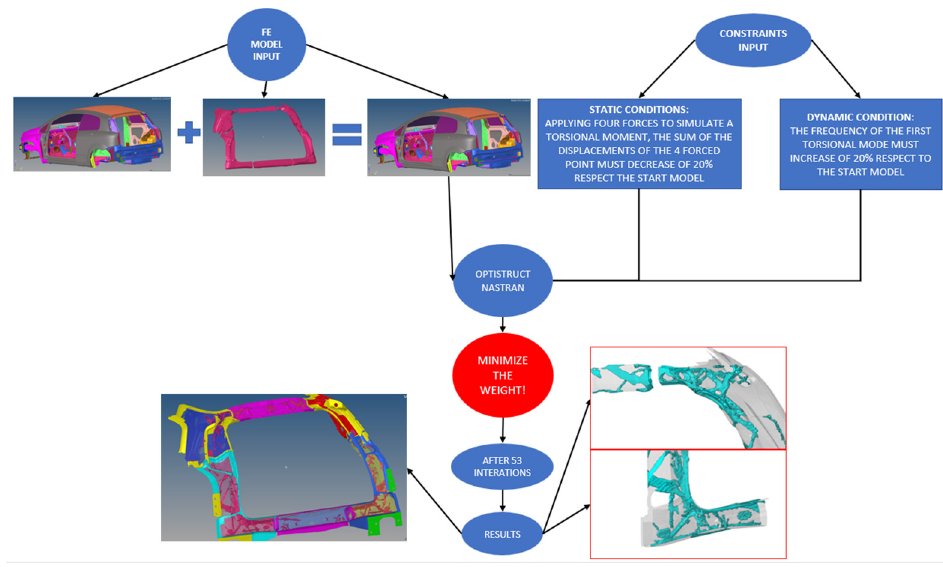
Figure 18. Flow chart of the optimization process.